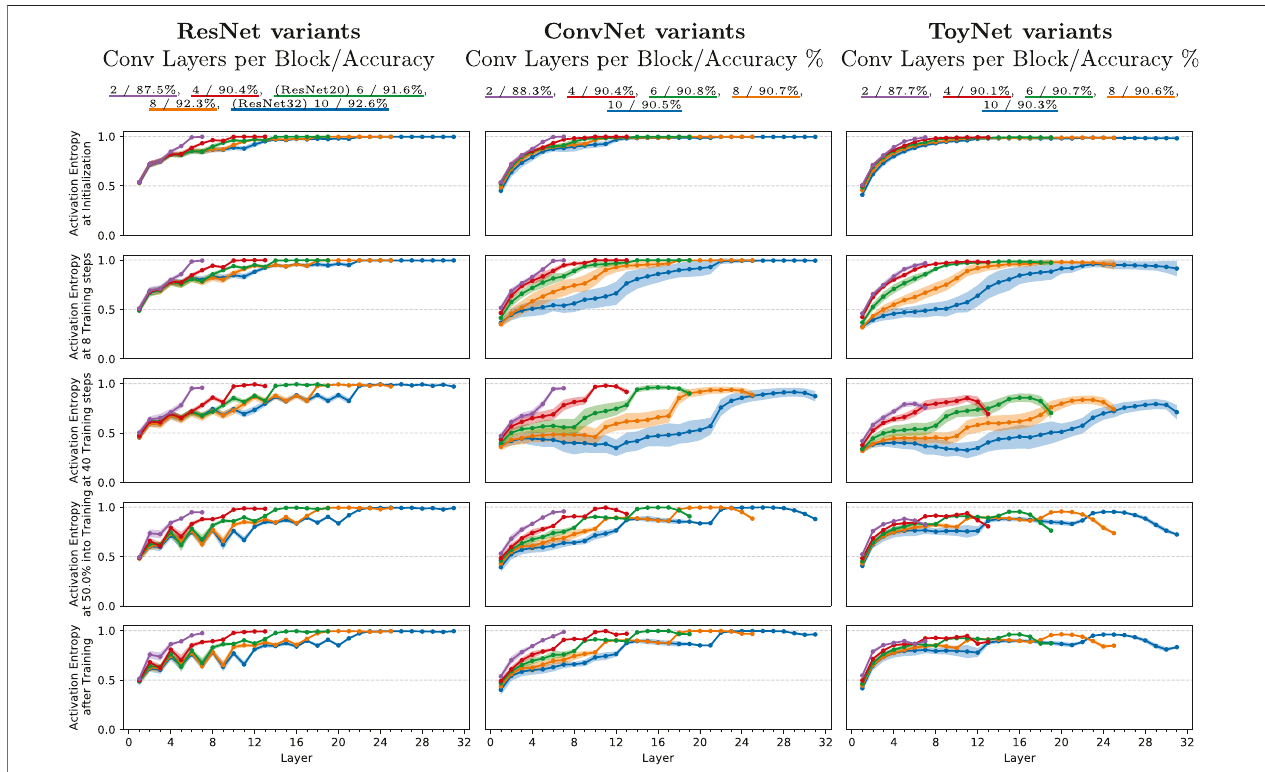
FIGURE 2 | Mean relative activation entropy for ResNets and ConvNets of various depth, measured for an ensemble of 25 training runs. The measurements were taken separately for each layer at different points of the training process: (i) at initialization; (ii) after 40 steps of stochastic gradient descent; (iv) after four epochs; and (iv) right after the fi rst learning rate drop at epoch 101. The shaded area indicates the variance spanning one standard deviation in each direction. The ResNet variants use the architecture proposed for CIFAR-10 by He et al. (2016a) and pre-activation shortcuts (He et al., 2016b), with a varying number of convolutional layers at each feature map size, shown in different colors. The ConvNets use the same basic architecture but without the residual